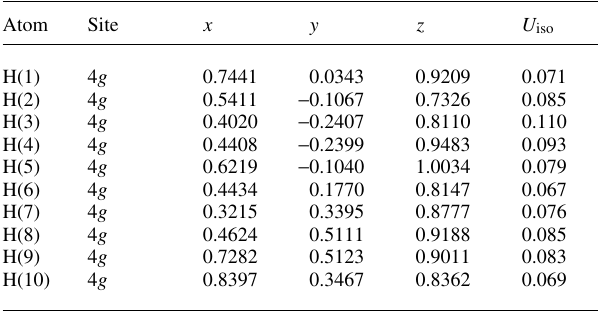
Table 2. Atomic coordinates and displacement parameters (in Å 2 )